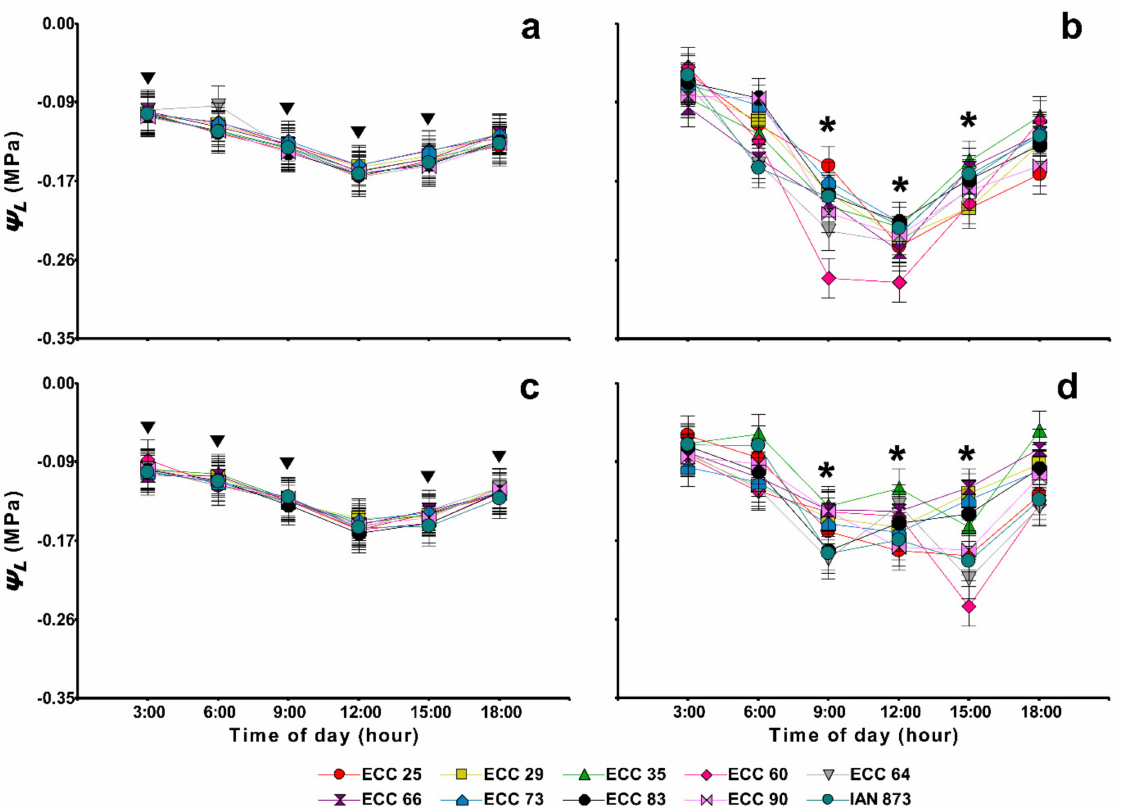
Figure 4. Diurnal leaf water potential ( Ψ L ) (MPa) in nine Hevea brasiliensis genotypes from the ECC-1 ( É lite Caquet á Colombia) selection and the cultivar IAN 873 (control)in two seasonal periods at two sites with different climates in Caquet á (Northwestern Colombian Amazon). ( a , b ), humid warm site (El Paujil); ( c , d ), semi-humid site (San Vicente del Cagu á n); ( a , c ), rainy period; ( b , d ), dry period. In each site, means for the rainy and dry periods followed by an inverted triangle and for the genotypes followed by an asterisk (*) for each time of day were significantly different according to Fisher’s LSD test, ( p < 0.05). Values represent the mean ± SE of four replications ( n =